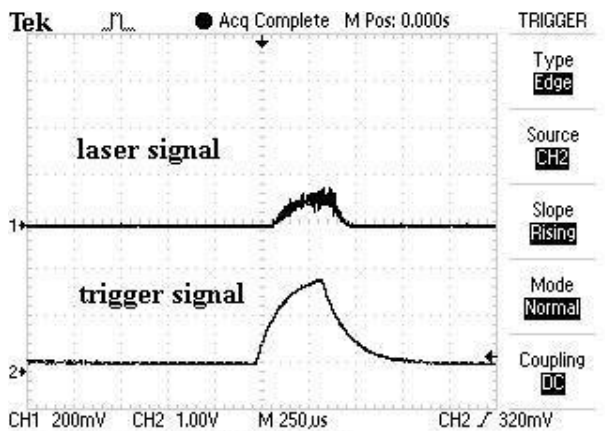
Figure 1. Trigger and laser signal (measured with